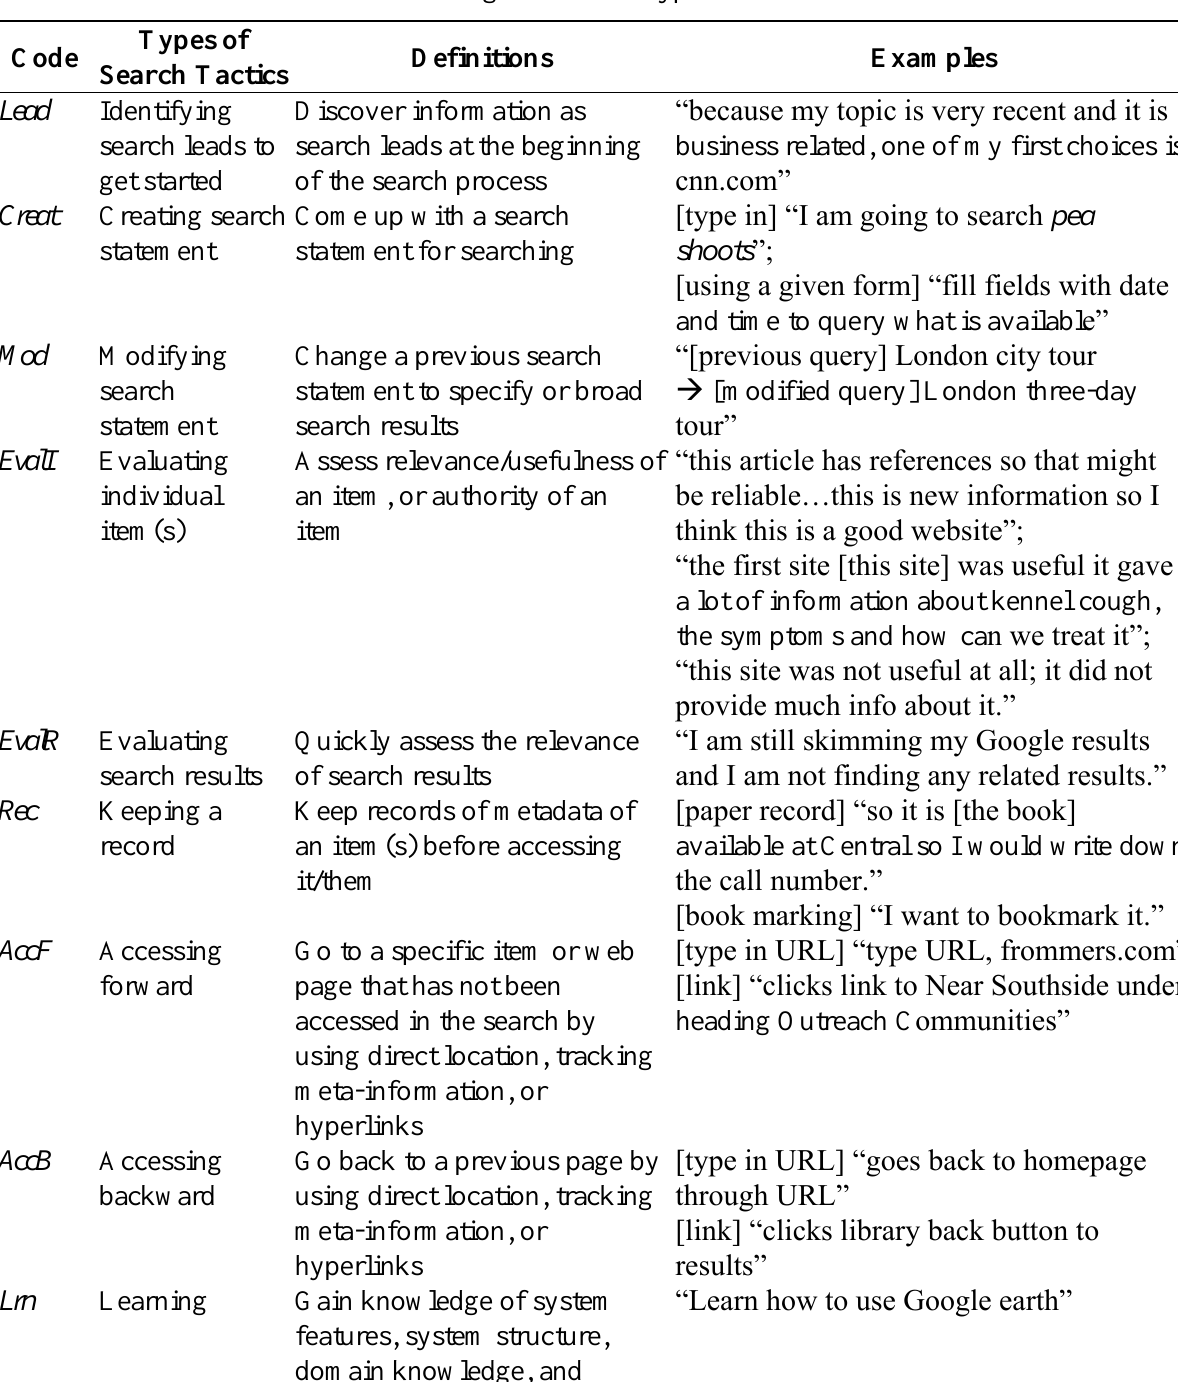
Table 3. Coding Scheme of Types of Search